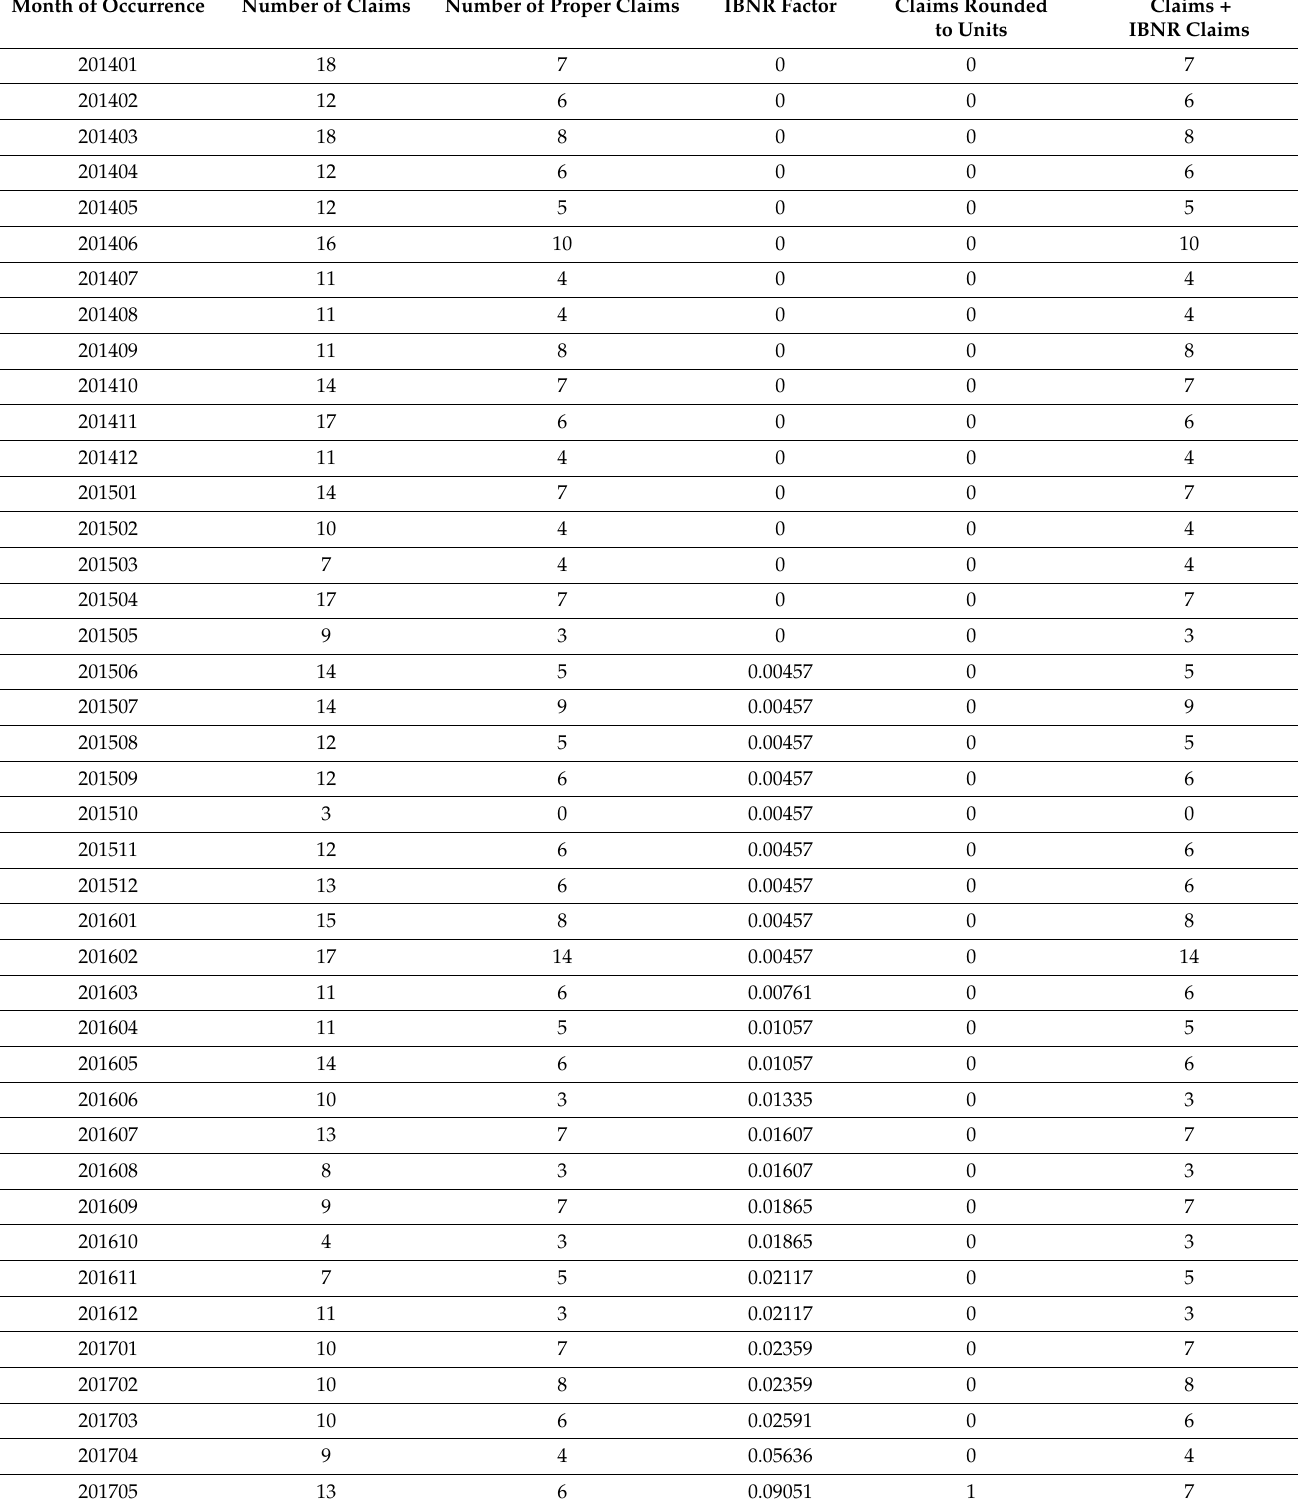
Table 1. Malpractice claims database presented by the month of occurrence; total number of claims (used to estimate the number of IBNR claims); number of proper claims; IBNR factor (obtained by the successive multiplication of the progression index); estimated number of IBNR claims (the proper claim number multiplied by the IBNR factor); sum of proper claims and IBNR